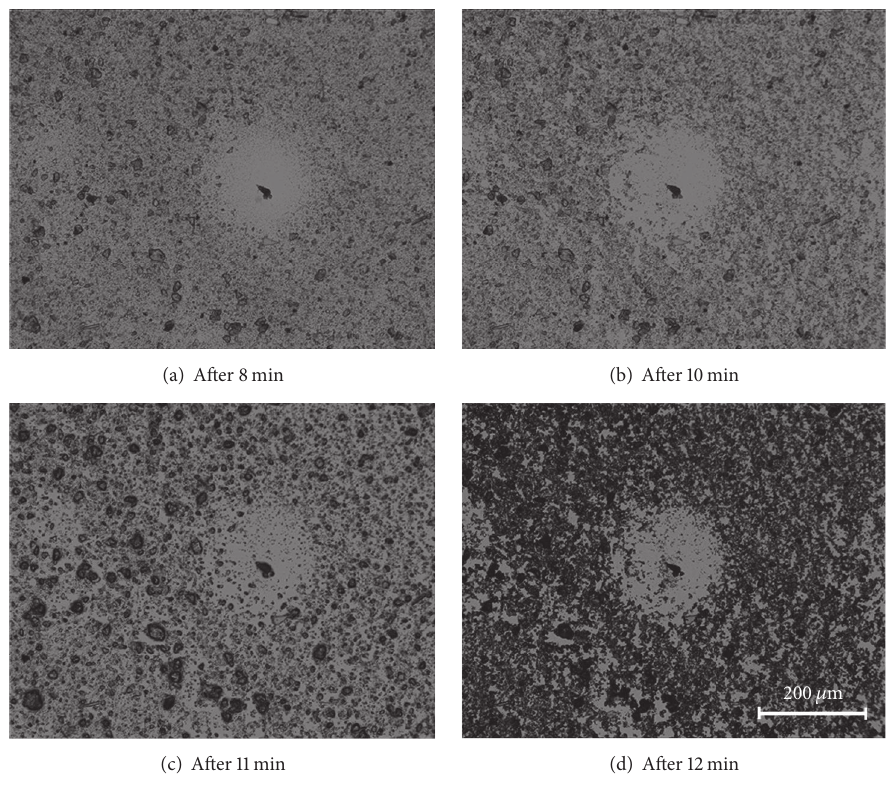
Figure 4: QELBY powder droplet evaporation viewed over time until the complete evaporation after 12 minutes.